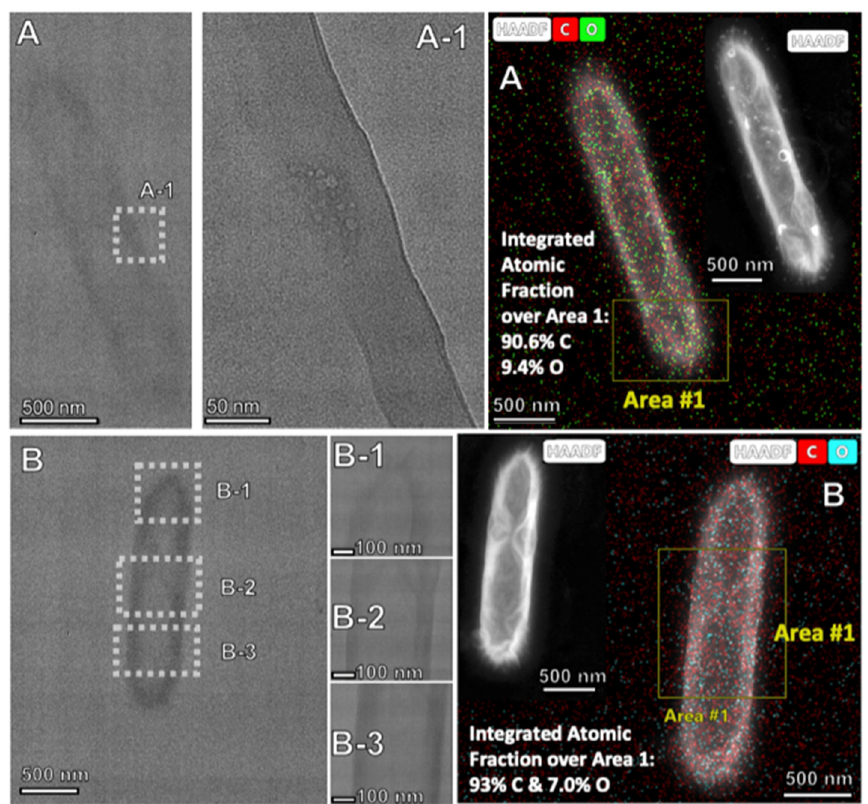
Figure 13. TEM and HAADF elemental analysis of nano-rod carbon allotrope synthesized by molten carbonate electrolysis. TEM and TEM HAADF elemental analysis of the Nano-rod carbon allotrope synthesized by molten carbonate electrolysis. ( A , B ) TEM with (right side) HAADF elemental analysis of Nano-rods; A-1, B-1, B-2, B-3 TEM of Nano-rods. Table 4. Raman spectra of a diverse range of carbon CNMs formed by molten electrolysis. CO 2 Molten Electrolysis Product